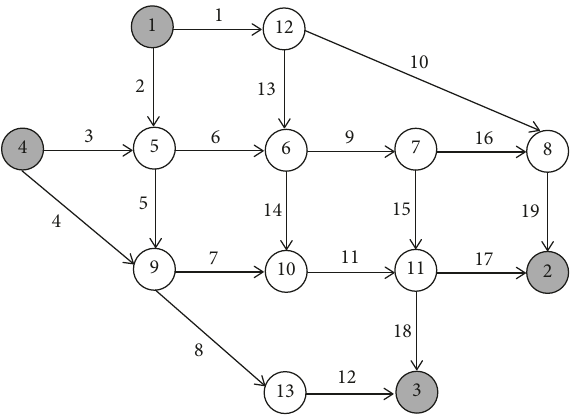
Figure 8: Test traffic network. Table 8: Parameters in link travel time functions.